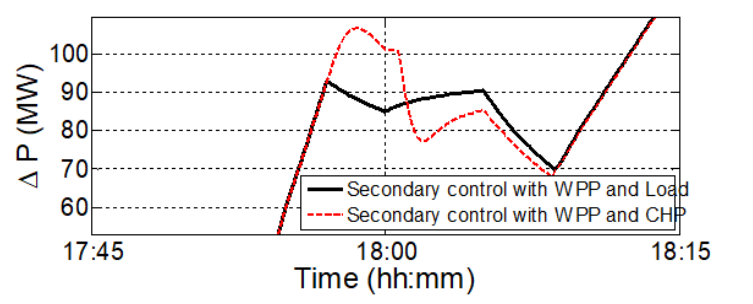
Figure 14. Zoom view of power exchange